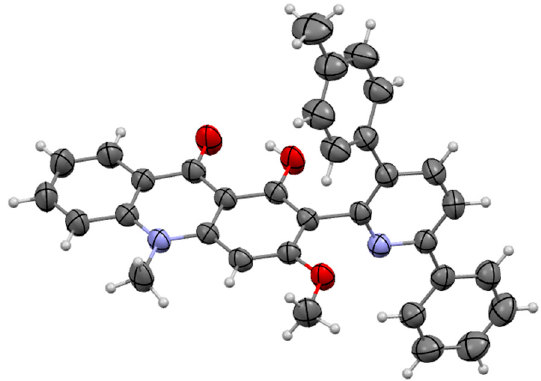
Figure 2. X-ray crystal structure of pyridine 10b (CCDC 2231907).